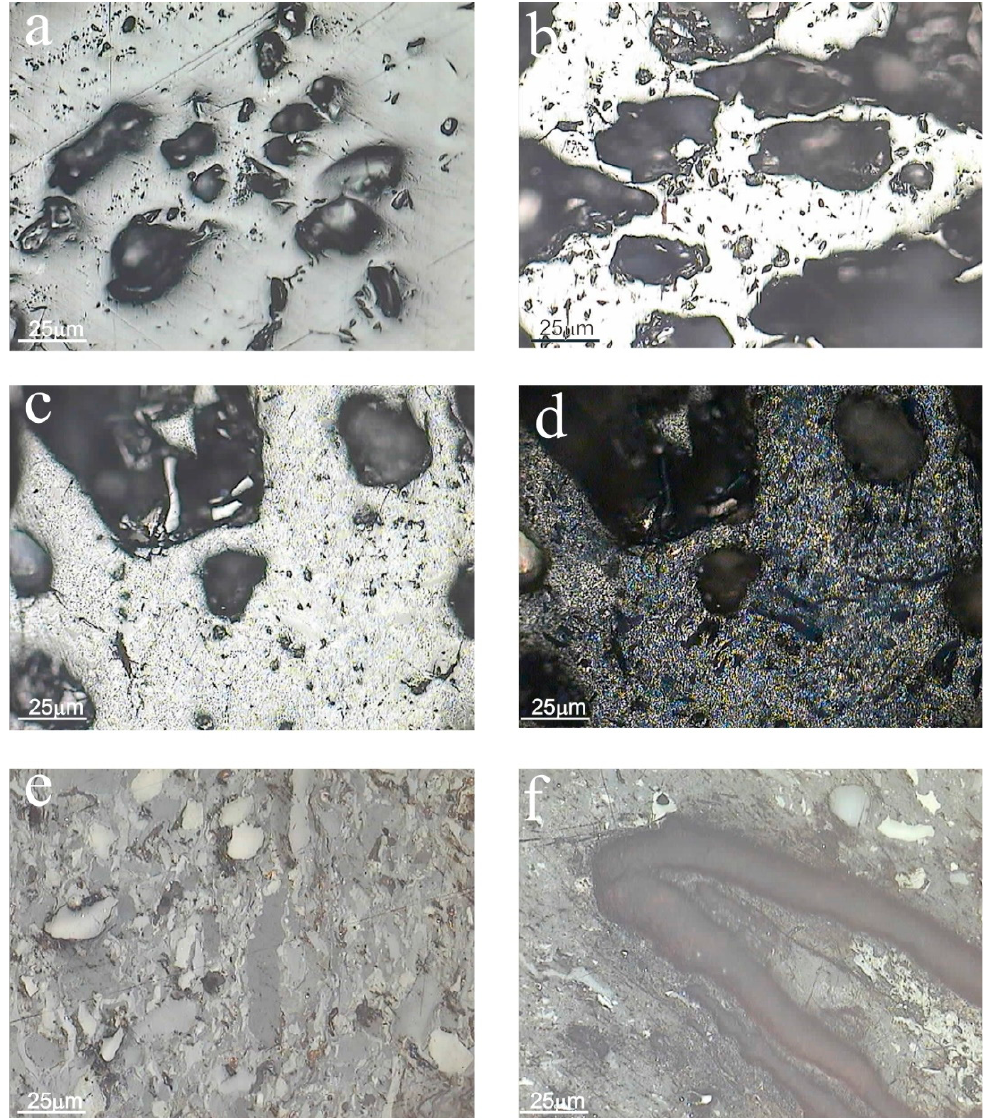
Figure 10. The residue after gasification of coal at a pressure of 40 bar. ( a ) Vitrinite with pores after degassing is visible; ( b ) heat-altered coal–coke structure is visible; ( c ) heat-altered coal–mesophase (matrix) is visible (parallel nicols); ( d ) the same field as photo c(crossed nicols); ( e ) trimacerite with the color and morphology of liptinite unchanged compared to the raw sample; ( f ) macrosporinite with the color and morphology of liptinite unchanged compared to the raw